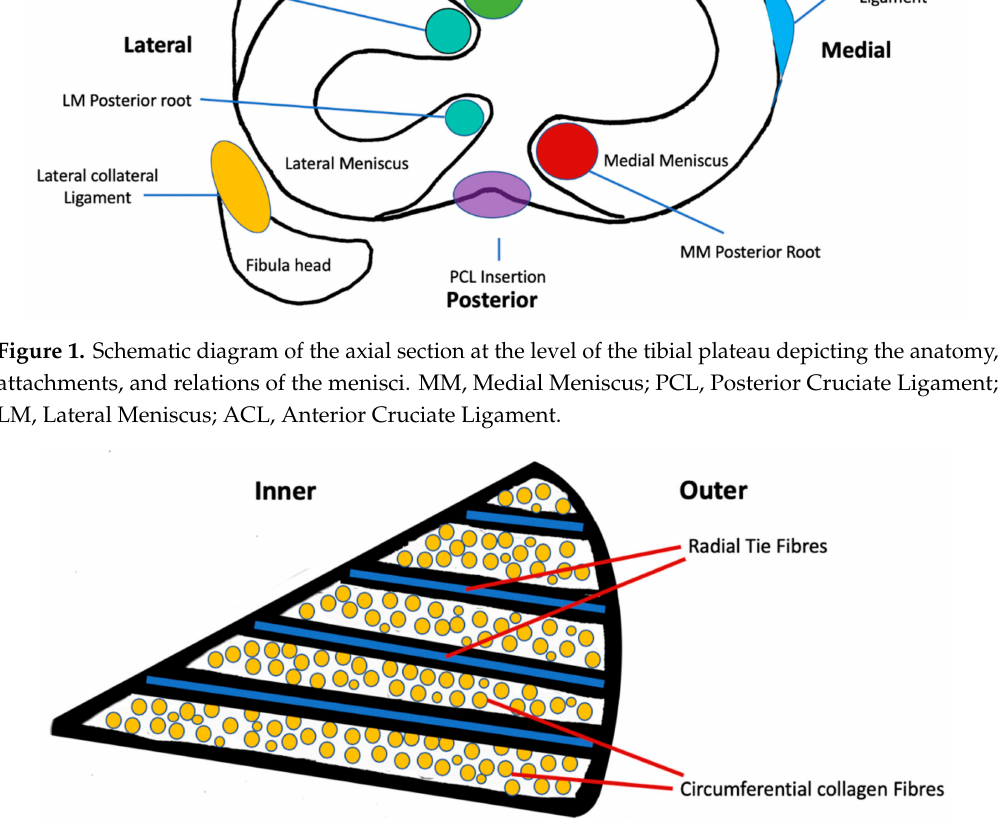
Figure 2. Schematic cross-sectional diagram of the meniscus displaying the circumferential arrangement of collagen fibers and radial tie